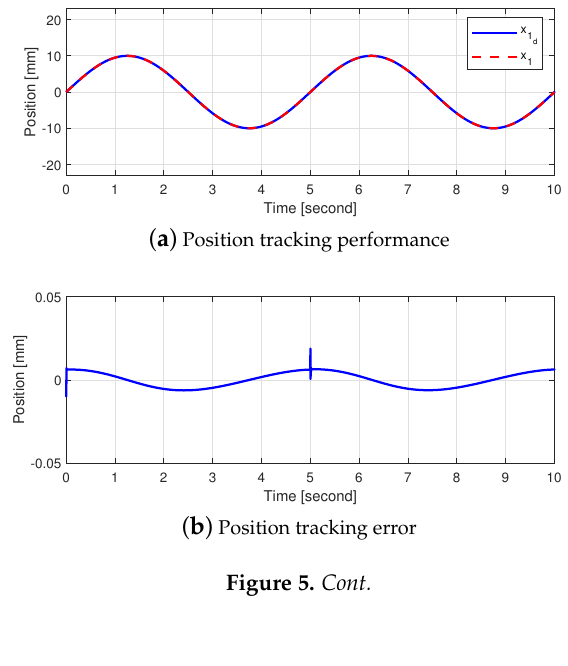
( b ) Position tracking error Figure 5.